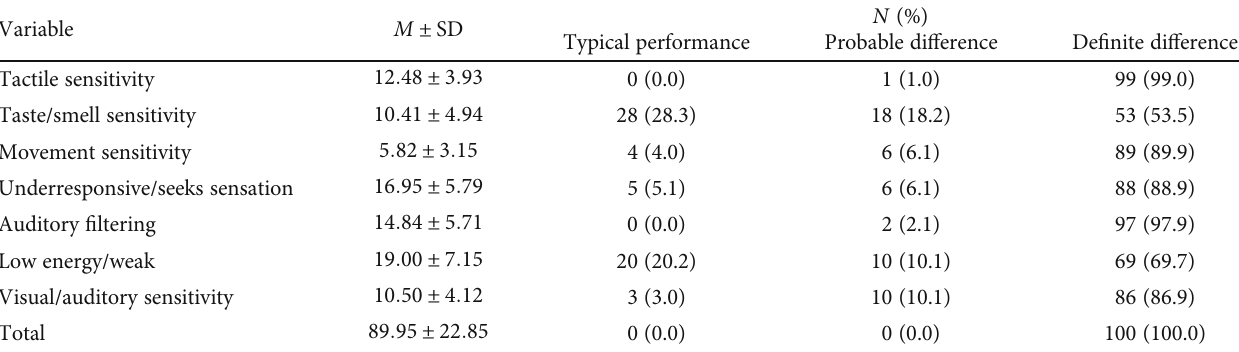
Table 3: Sensory pro fi le of subjects ( N = 99